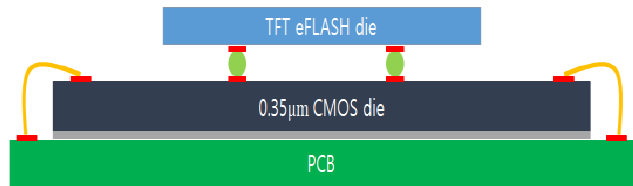
Figure 13. Hybrid bonding technology.